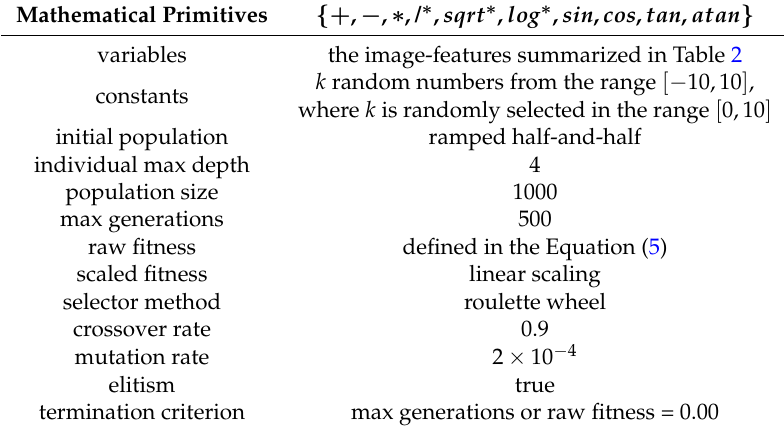
Table 4. The Genetic Programming (GP) parameters used for the evolution of the binary classifiers for the jelly recognition task. Mathematical Primitives variables the image-features summarized in Table